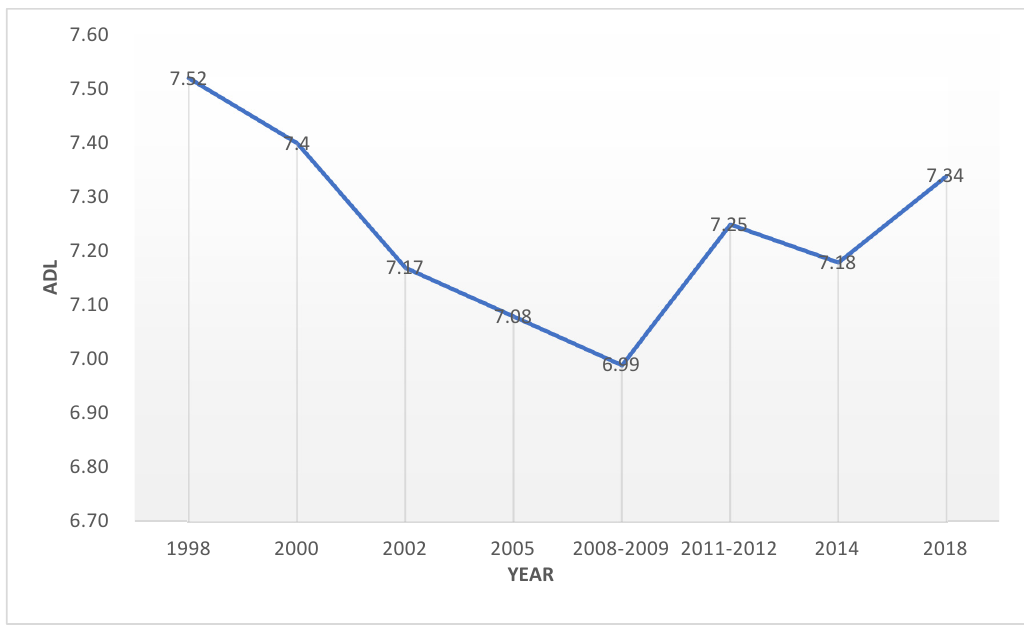
Figure 1. Elderly HCD in China (1998–2018).